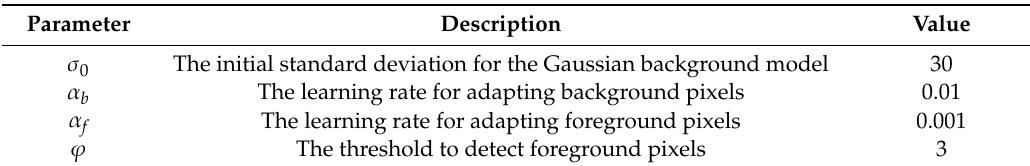
Table 1. Suggested parameters for the IPGBBS algorithm.